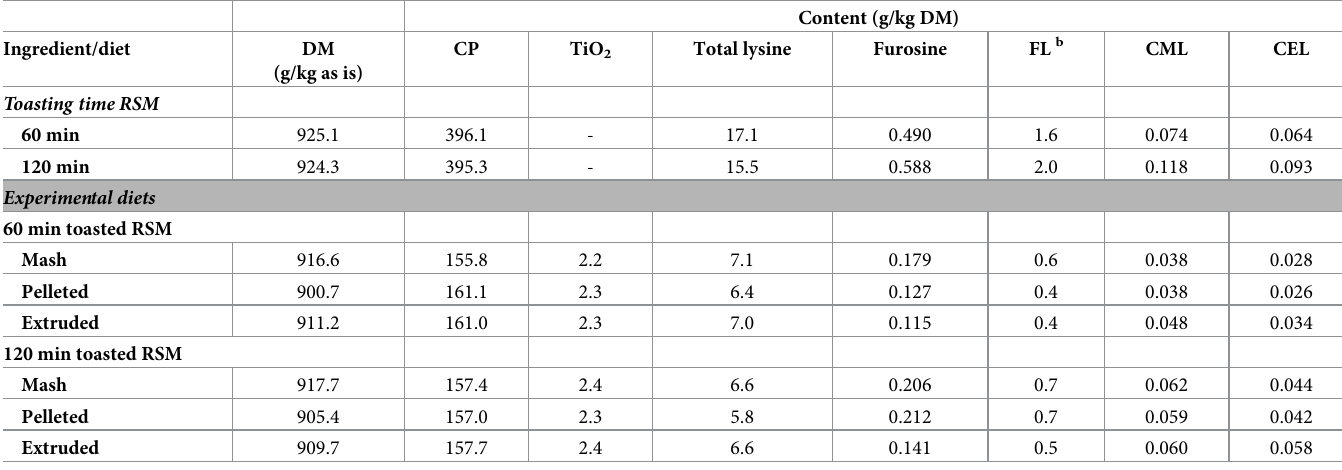
Table 3. Chemically analyzed composition of the RSM and the experimental diets a